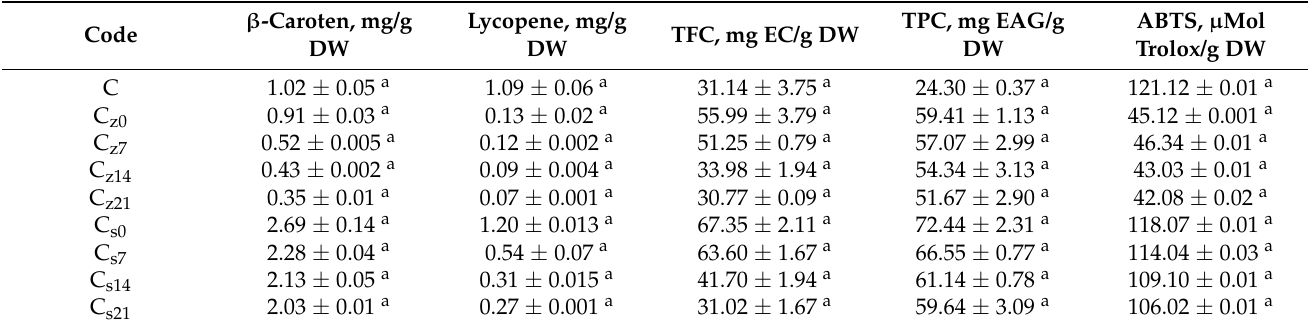
Table 1. Phytochemical properties of the marmalade